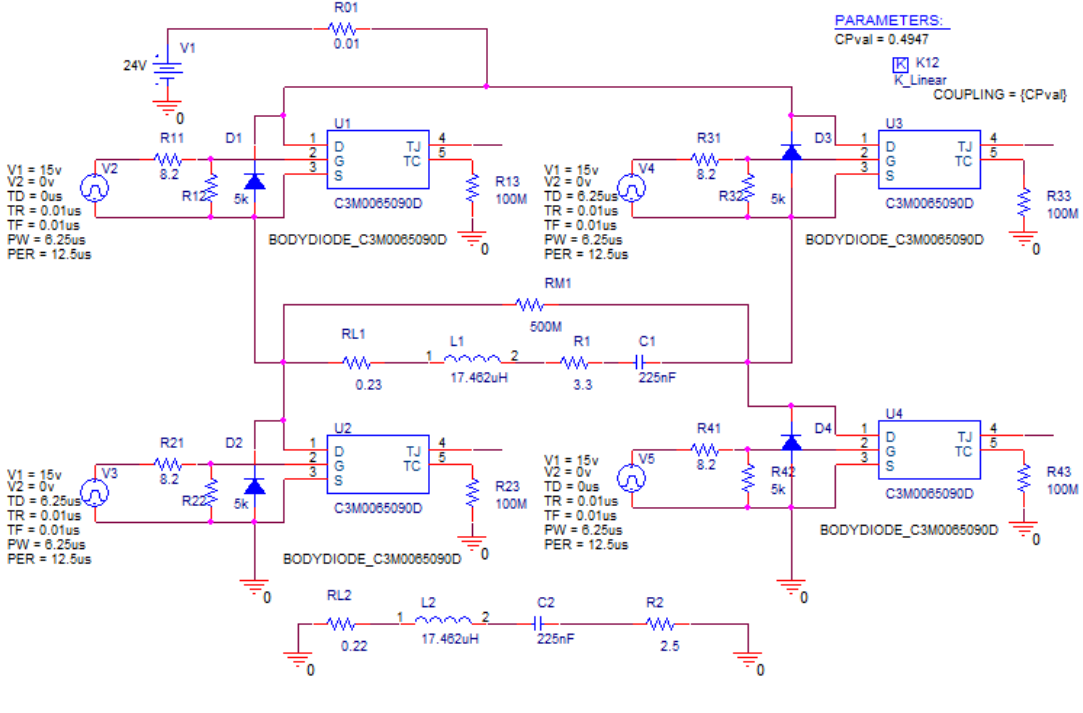
Figure 5. Simulation schematic